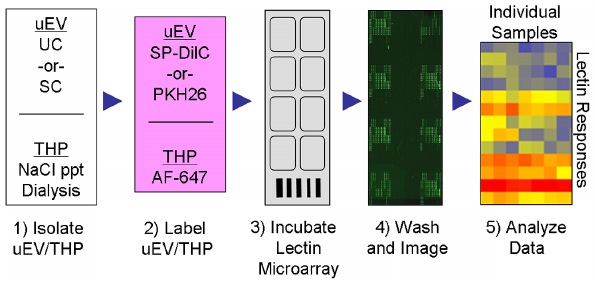
Figure 4. Schematic of lectin microarray profiling process.